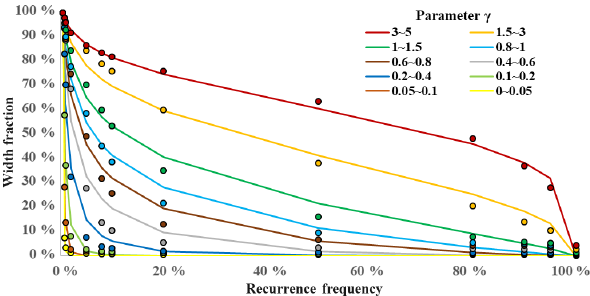
Figure 10. Curve characteristics for different river morphology cat- egories (line: prediction; dot: